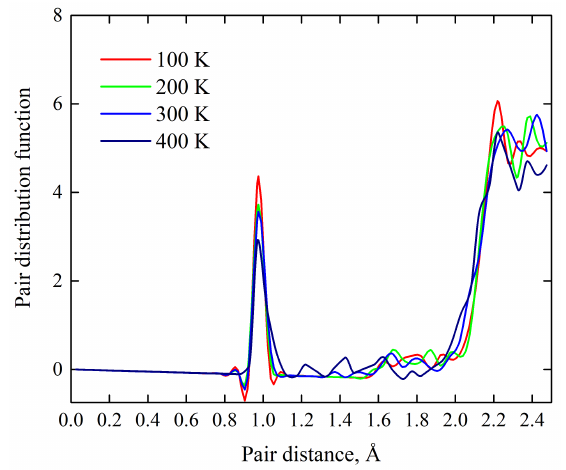
Figure 4. Temperature behavior of the pair distribution function for the O − H, Y − H, and Y − O bond distances as it follows from MD simulations performed over the range 0–400 K.